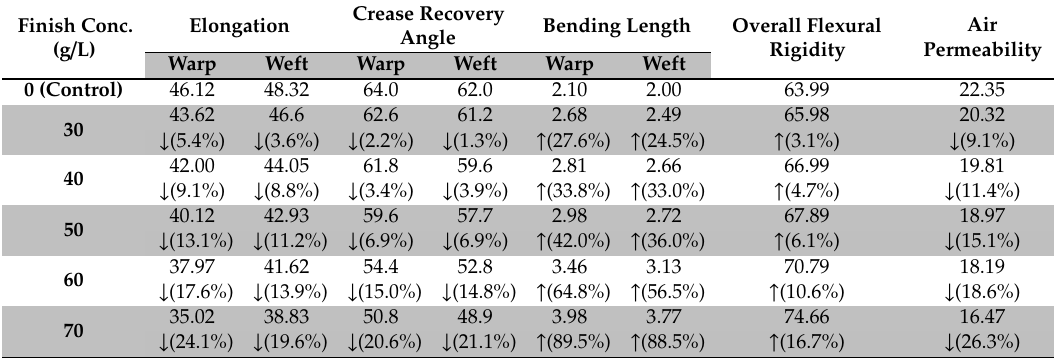
Table 4. E ff ect of di ff erent finish concentrations on the selected physical properties of polyester / cotton woven